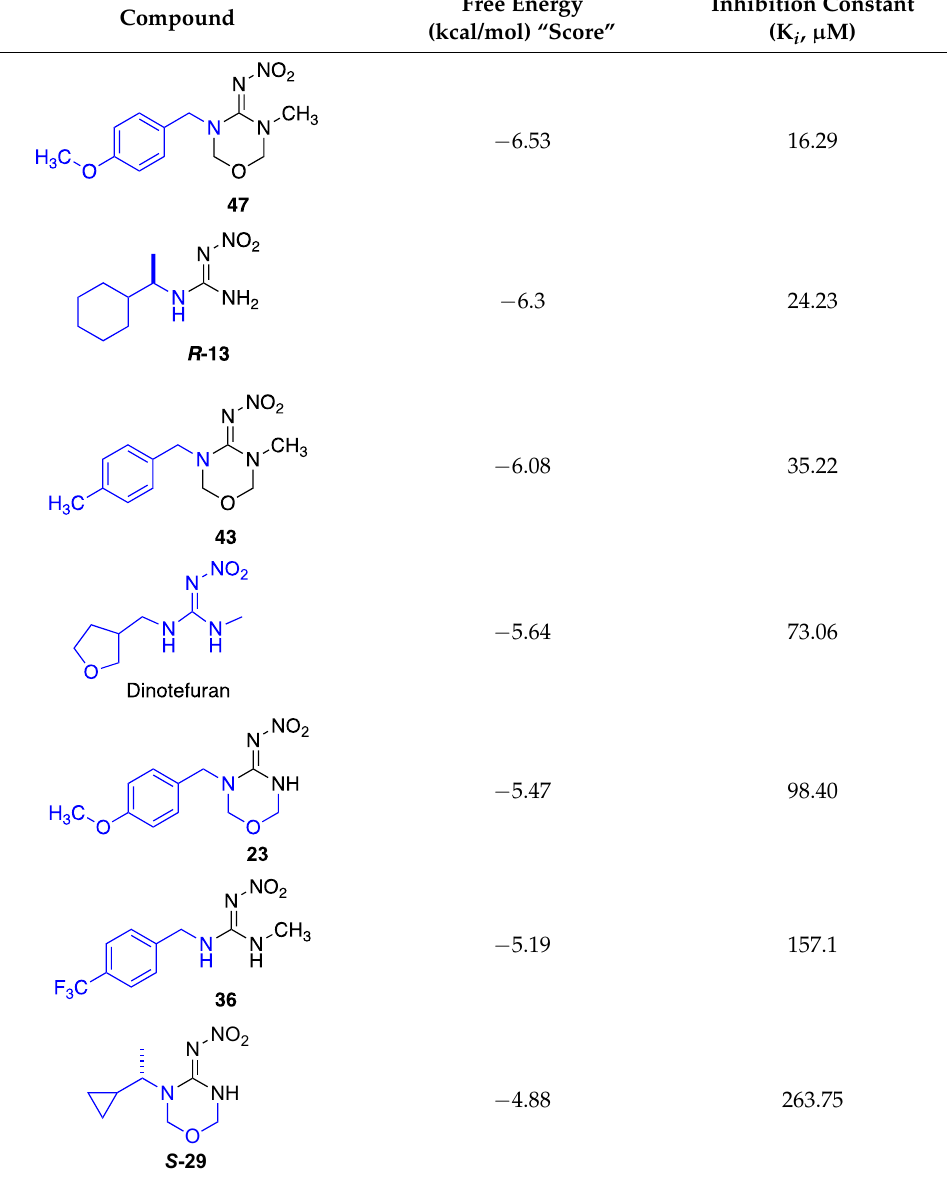
Table 1. Affinity and inhibition constants of highly bioactive compounds a .